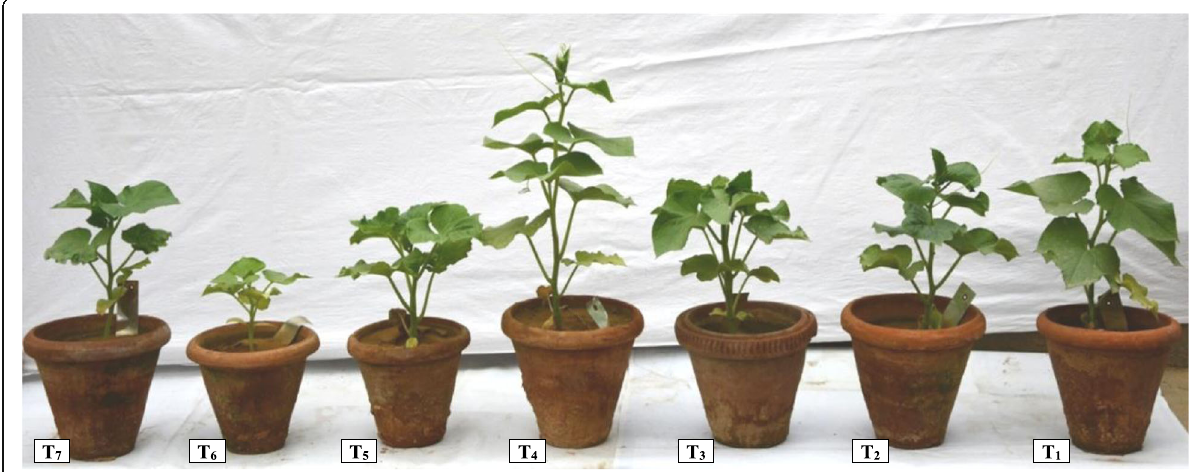
Fig. 2 Effect of Fictor composticola and organic amendments in different combinations on plant growth of cucumber infected with Meloidogyne incognita . T1, F. composticola + neem cake + neem leaves; T2, F. composticola + chicken manure + neem cake; T3, F. composticola + neem leaves + chicken manure; T4, F. composticola + chicken manure + neem cake + neem leaves; T5, F. composticola alone; T6, inoculated control; T7, un-inoculated